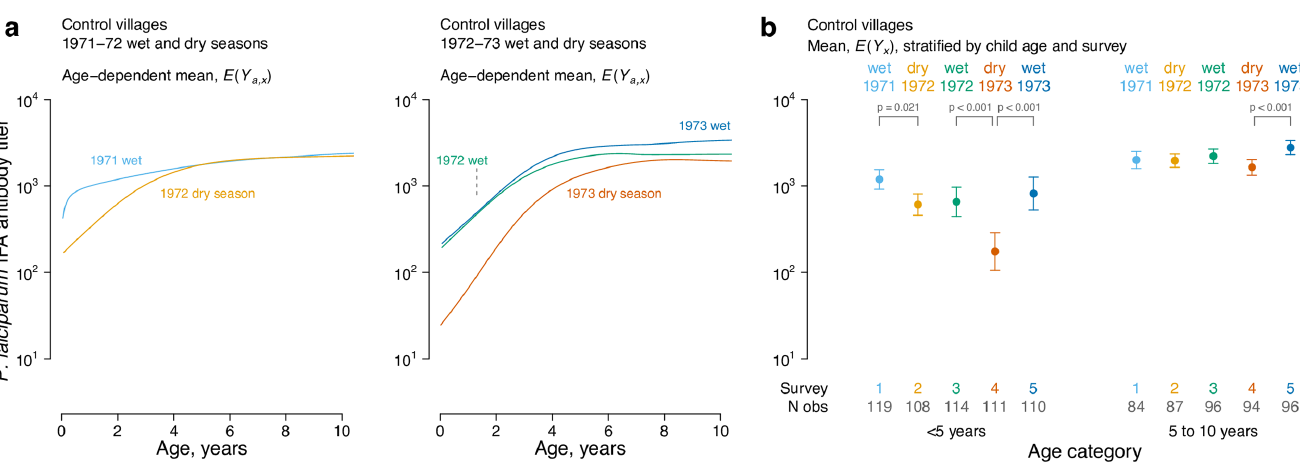
Fig 4. Higher sensitivity among children < 5 y to seasonal changes in Plasmodium falciparum transmission as depicted by age-antibody curves estimated within control villages in the Garki Project, Nigeria (1970–1976). Antibody responsemeasuredwith the IgG indirect fluorescent antibody (IFA) test for P . falciparum . a, Mean antibody levels by age ( a ) and season ( x ), E ( Y a , x ). b , Age-adjusted geometricmeans by age category and season, E ( Y x ), summarize the curves. Error bars show 95% confidenceintervals and P -valuesmark significantdifferences(Bonferronicorrected) betweenadjacent seasons. The source data used to generatethis figure are here: https://osf.io/8tqu4(garki), and the scripts used to generate the figure are here: https://osf. io/ek3sx